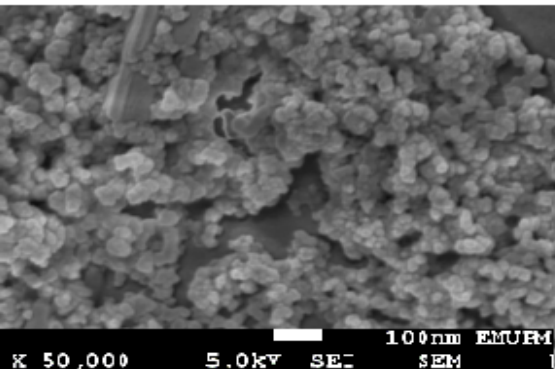
Figure 6. Surface morphology of nanocrystalline tin oxide thin film at the optimum conditions.